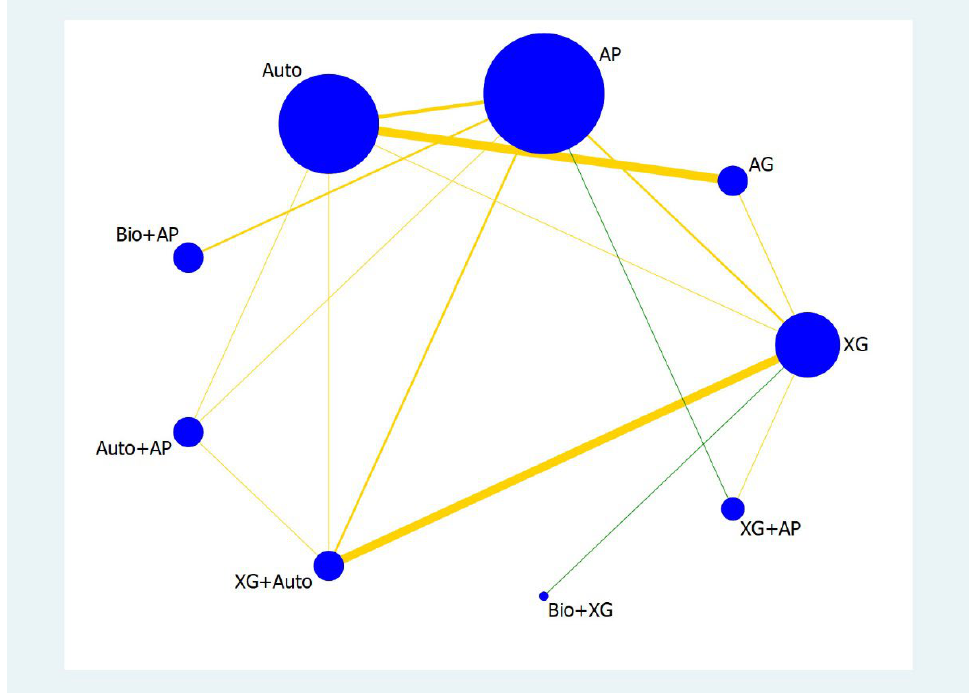
Figure 3. Network plot for the ≥ 4 mm RBH. The meaning of the circle and line size is as in Figure 2. The yellow colour indicates a moderate risk of bias and the green colour indicates a low risk of bias. The number of samples was higher for XG, AP, auto, and Bio+XG for <4 mm RBH outcome and the most frequent comparisons were between XG and AP; XG and XG+AP;